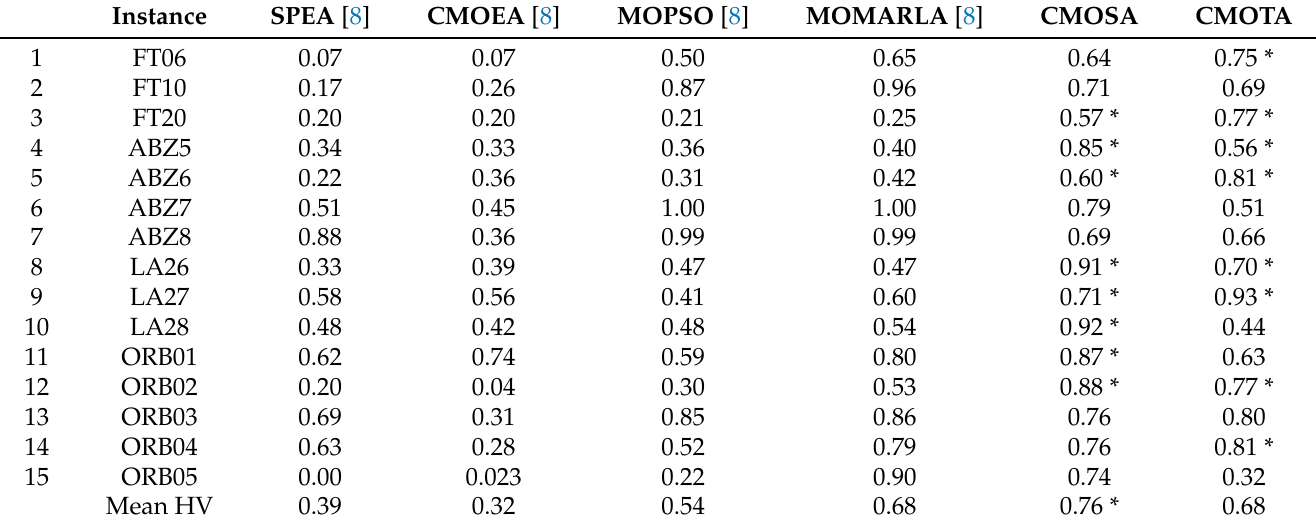
Table 9. Comparison among SPEA, CMOEA, MOPSO, CMOSA, CMOTA, and MOMARLA using HV.